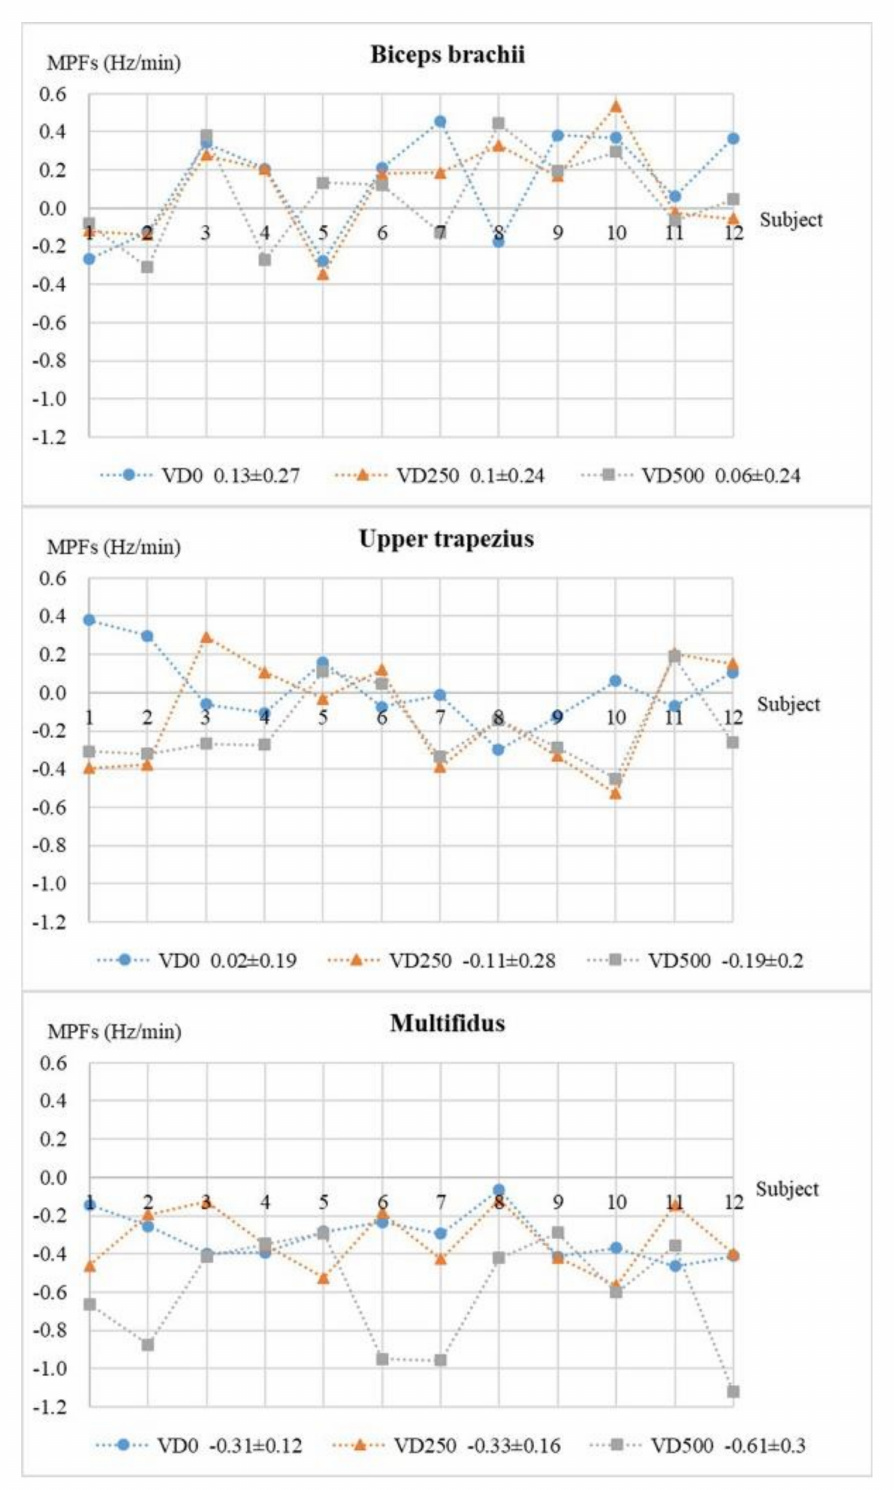
Figure 9. The fatigue rates (MPFs) of target muscles (biceps brachii, upper trapezius, multifidus), combined all the subjects, in three tested